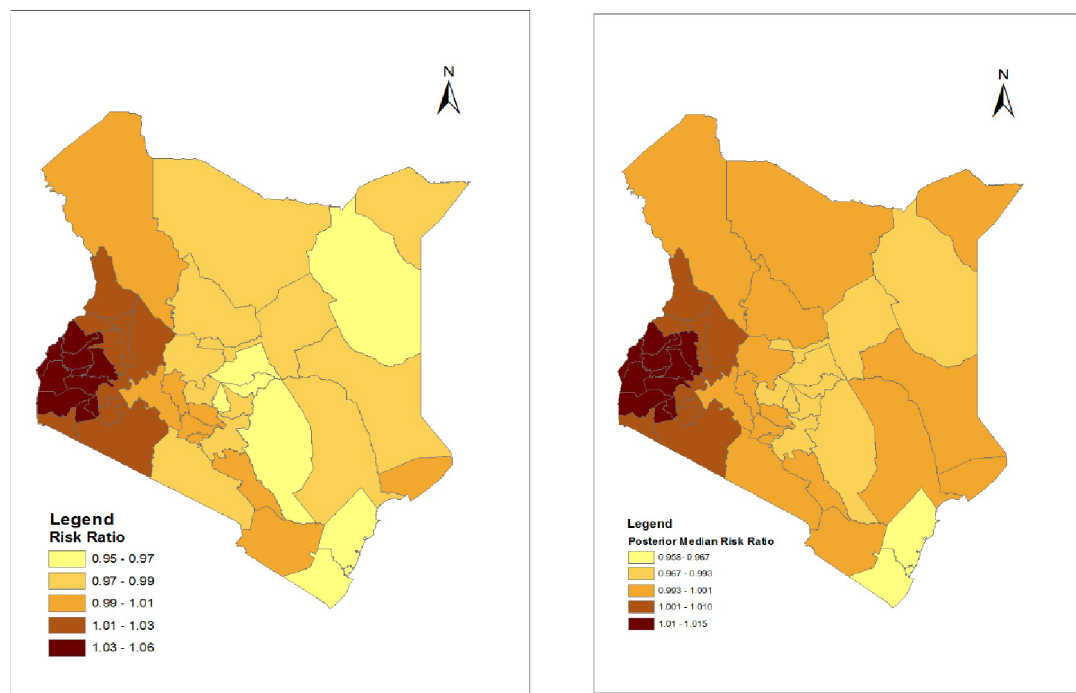
Fig 1. Structured and unstructured (convolution) spatial effect on odds of adoption of a highly effective contraceptive method- Posterior mean risk ratios.